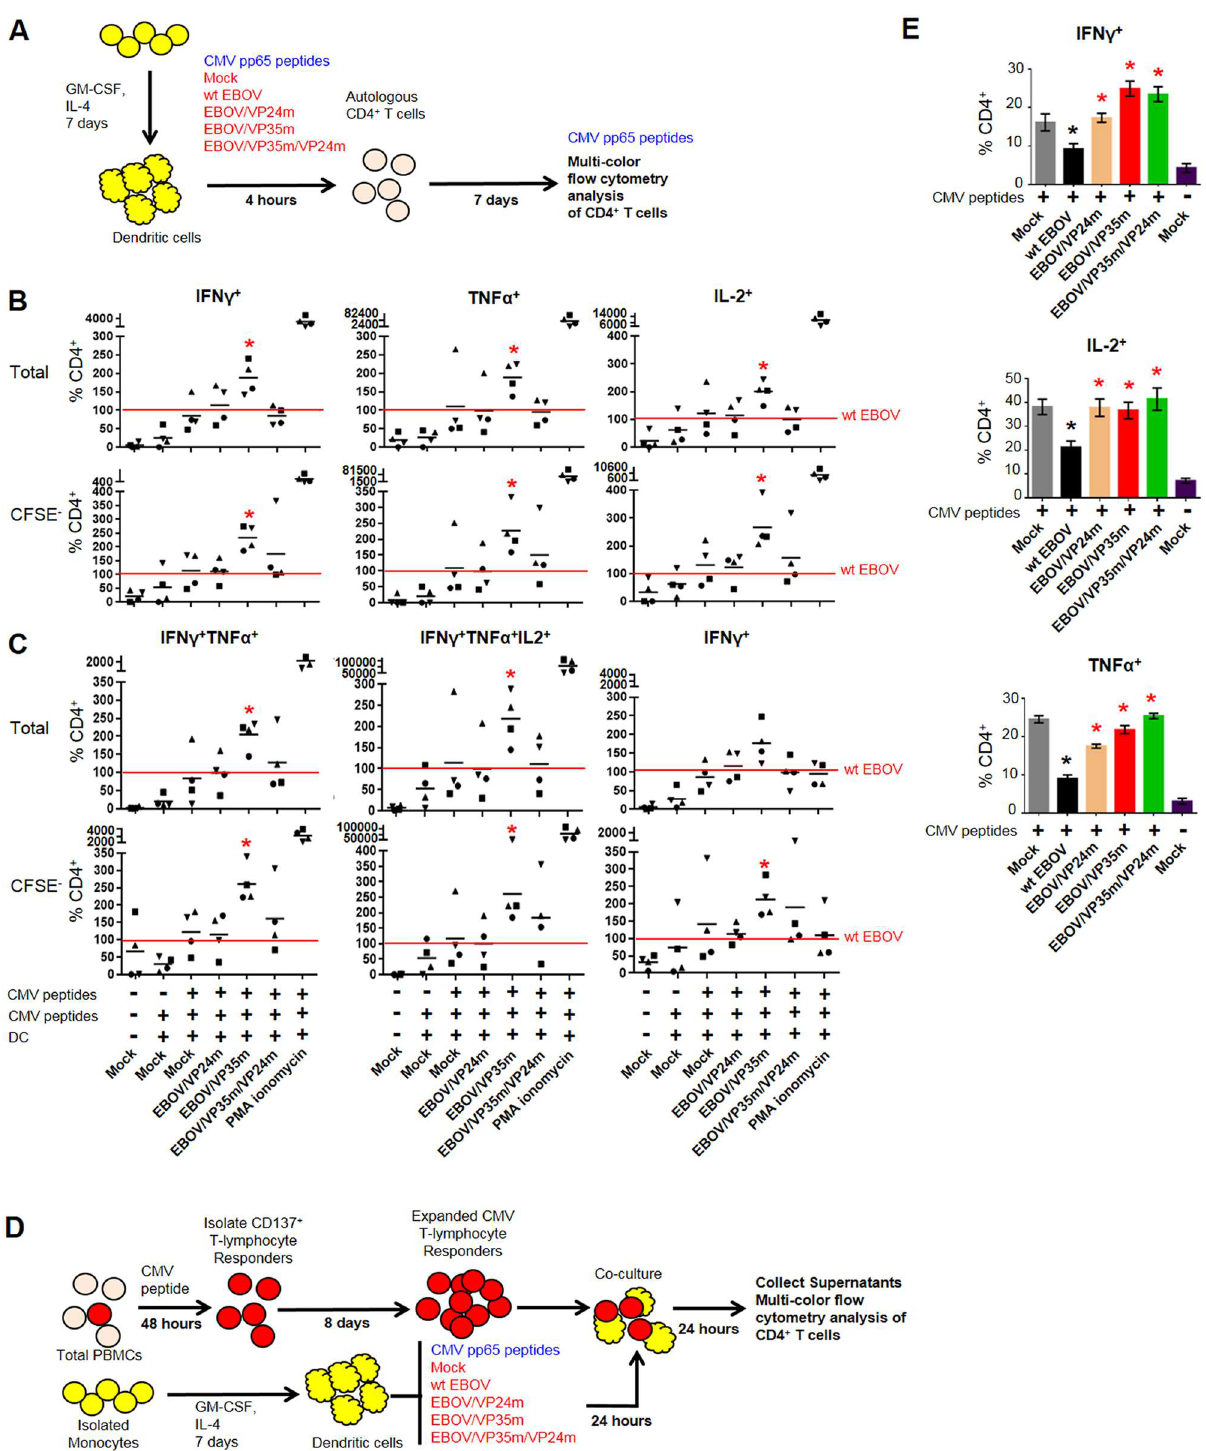
Fig 3. The VP35-mediated reduction of Th1 response results from the deficient maturation of DC. A. Schematicrepresentation of the cultivationexperiment: immature DCs from CMV-positivedonorswere inoculated with the indicatedviruses and stimulatedwith CMV pp65 peptides for 4 hours, washedand co-culturedwith CFSE-labeled autologouspurifiedCD4 + T cells for 7 days. Thereafter, cells were processedand analyzedas describedin the legendfor Fig 2B. B. Percentagesof total and proliferating (CFSE - ) CD4 + T cells secretingtotal IFN γ , IL-2 or TNF α individuallynormalizedto wt EBOV in the same donor; see legendfor Fig 2C for details. C . Analysis of total and